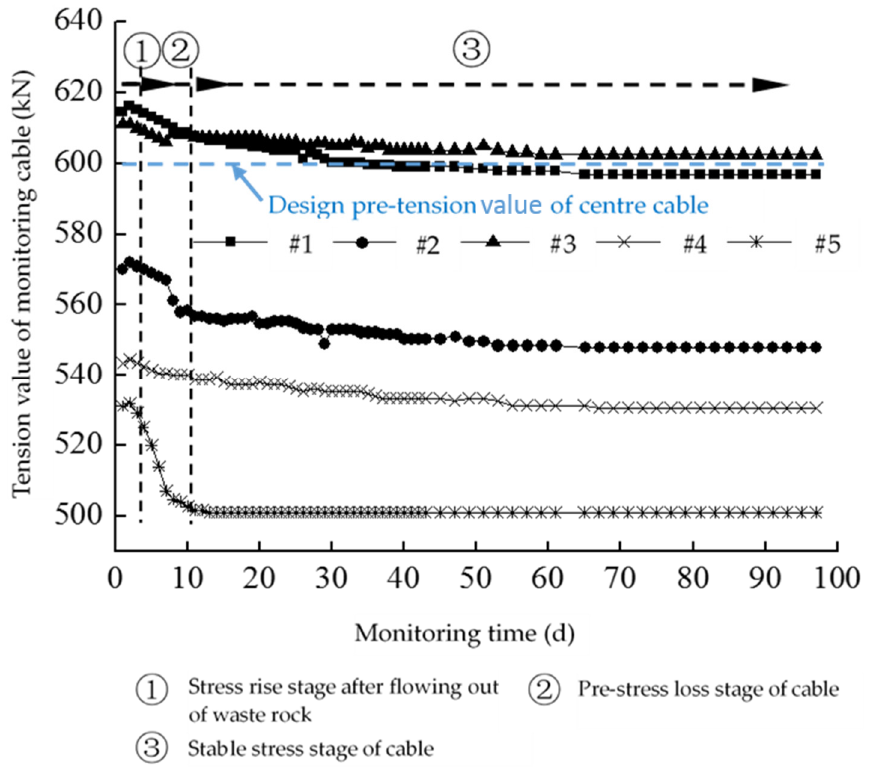
Figure 14. Tension-time curve of monitoring cable.